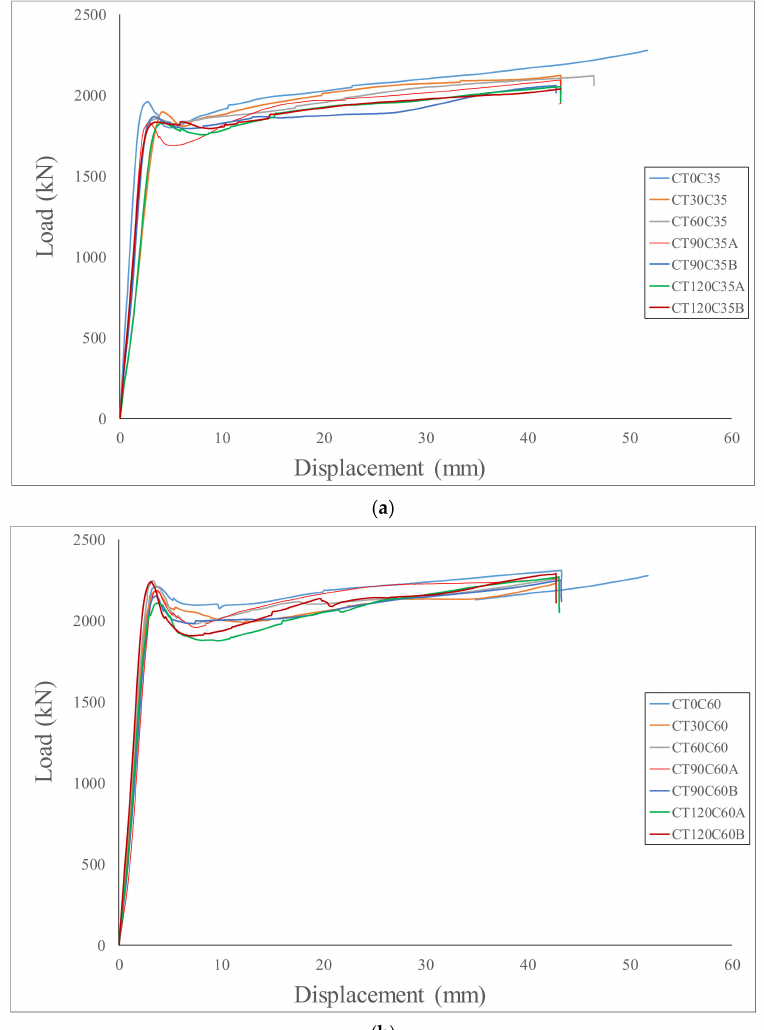
Figure 7. Load versus displacement curves of specimen CT series: ( a ) C35 Series; ( b ) C60 series.